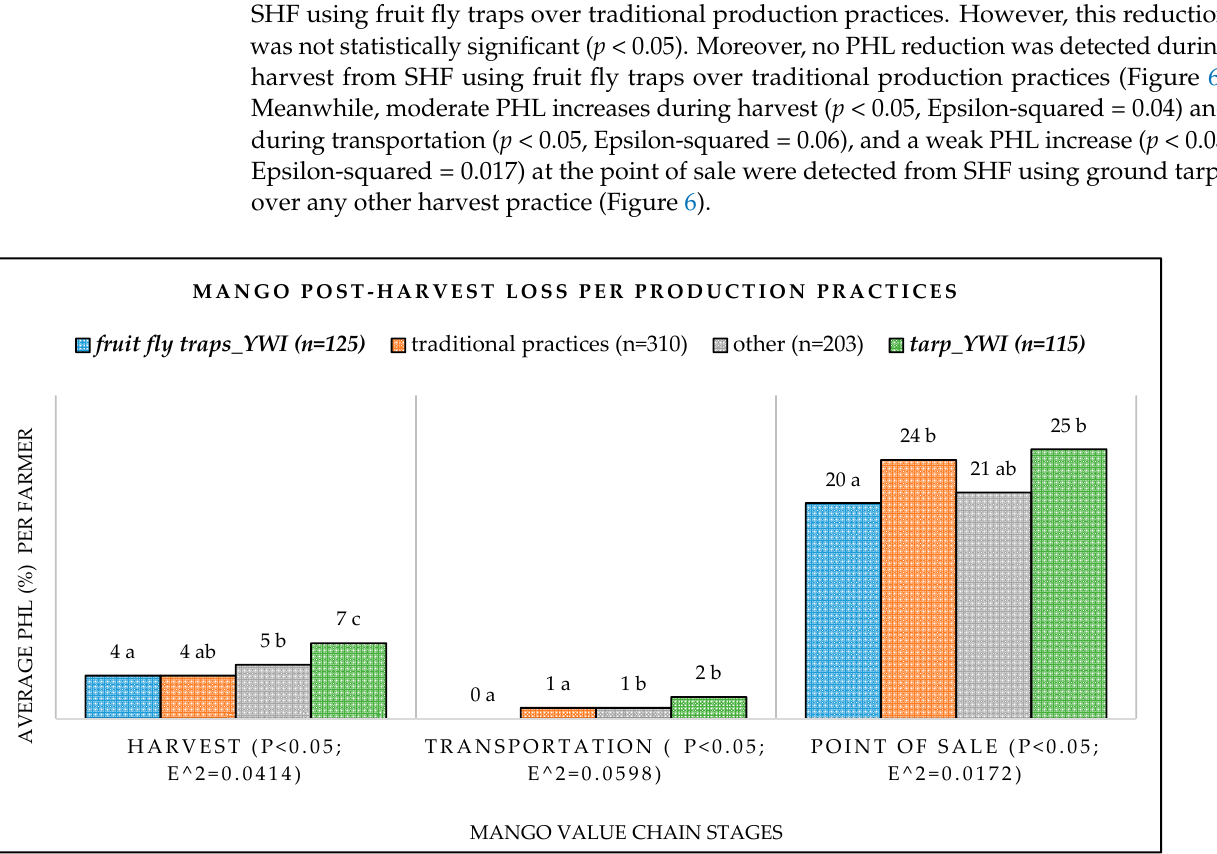
Figure 6. Comparing fruit fly traps to alternative production practices. Values with different letters are significantly different at p < 0.05 from the Kruskal–Wallis analysis, Dunn test, and Benjamini–Hochberg adjustment. E^2 = Epsilon-squared value for effect size. YWI refers to the technology that the Yieldwise Initiative promoted. ( n ) refers to the number of farmers who reported using a given practice or technology. ‘Other’ refers to practices that combined both YWI promoted technologies and traditional practices.